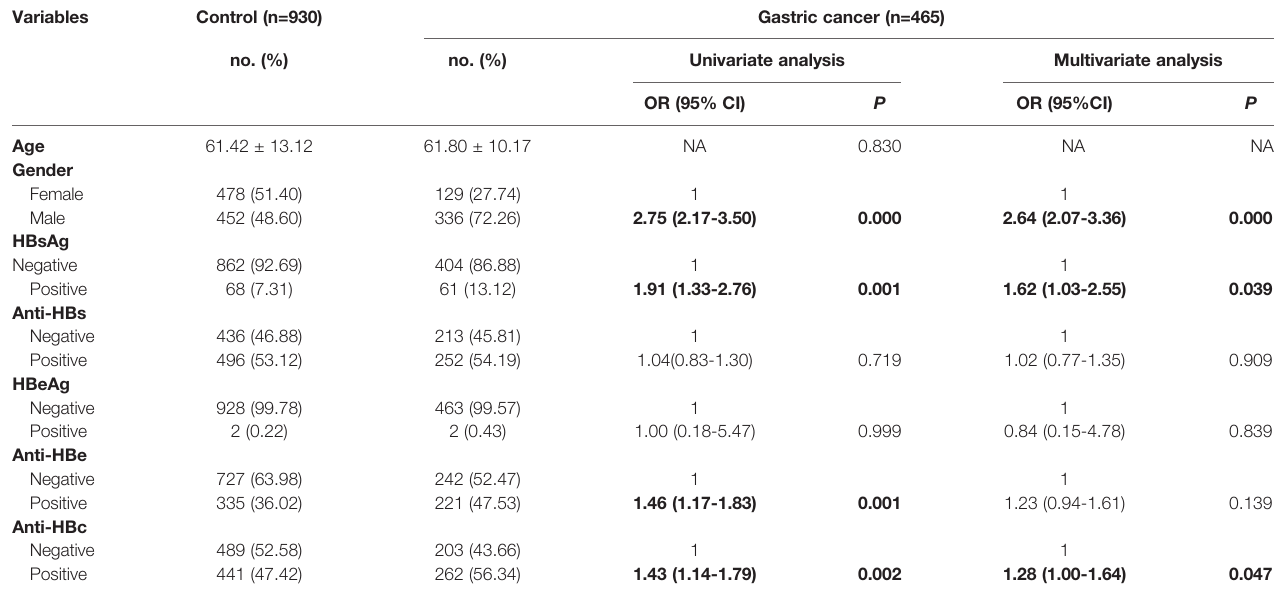
TABLE 1 | Prevalence of HBV infection in gastric cancer patients and